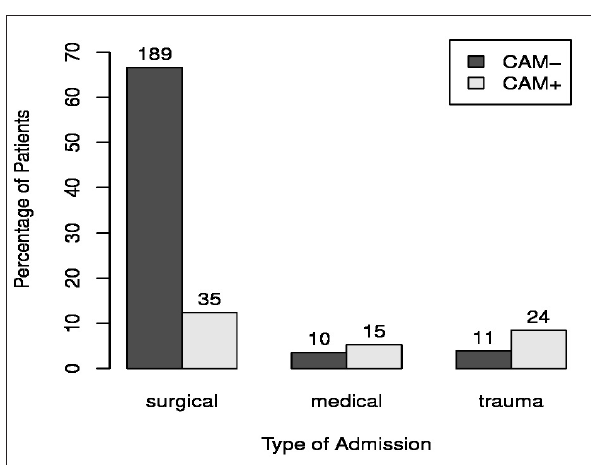
Fig. 2. Numbers of patients by the type of admission.